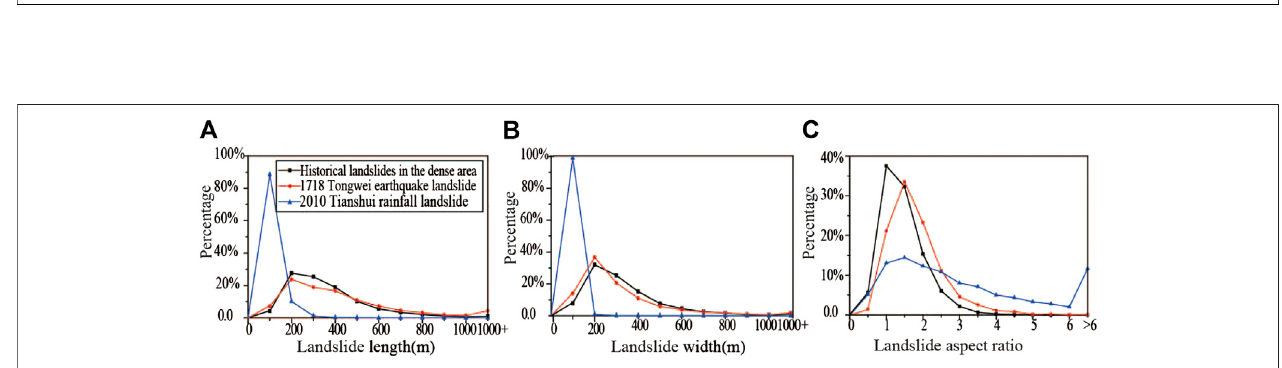
FIGURE 10 | Comparison of the lengths, widths, heights, and aspect ratio of landslides: (A) comparison chart of landslide lengths; (B) comparison chart of landslide widths; and (C) comparison chart of landslide aspect ratios.